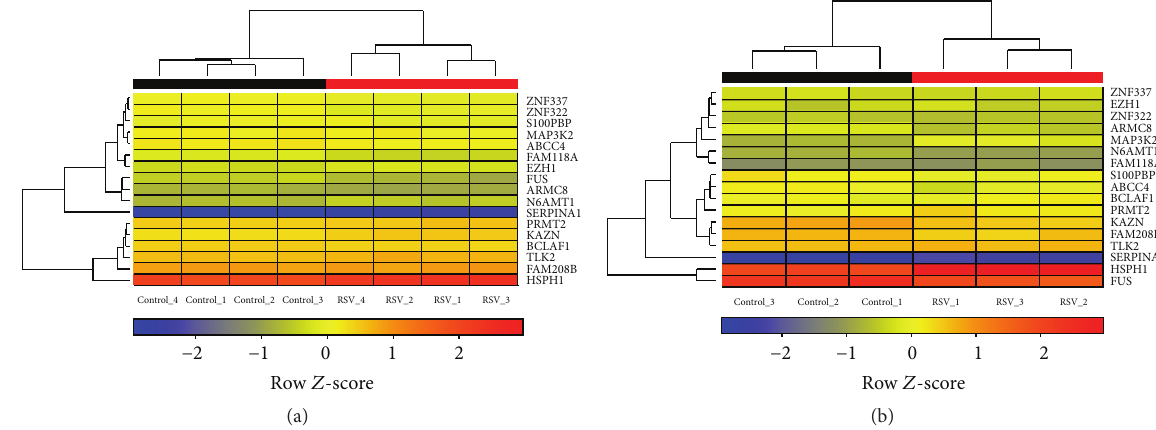
Figure 4: Biomarker signature of BEAS-2B cells infected with RSV for 4h. Hierarchical clustering of expression data for ABCC4 , ARMC8 , BCLAF1 , EZH1 , FAM118A , FAM208B , FUS , HSPH1 , KAZN , MAP3K2 , N6AMT1 , PRMT2 , S100PBP , SERPINA1 , TLK2 , ZNF322 , and ZNF337 from (a) dataset GSE3397 and (b) dataset GSE6802. Row 𝑍 -scores were calculated based on normalized expression data. The colors from blue to red represent the transition of decreased to increased